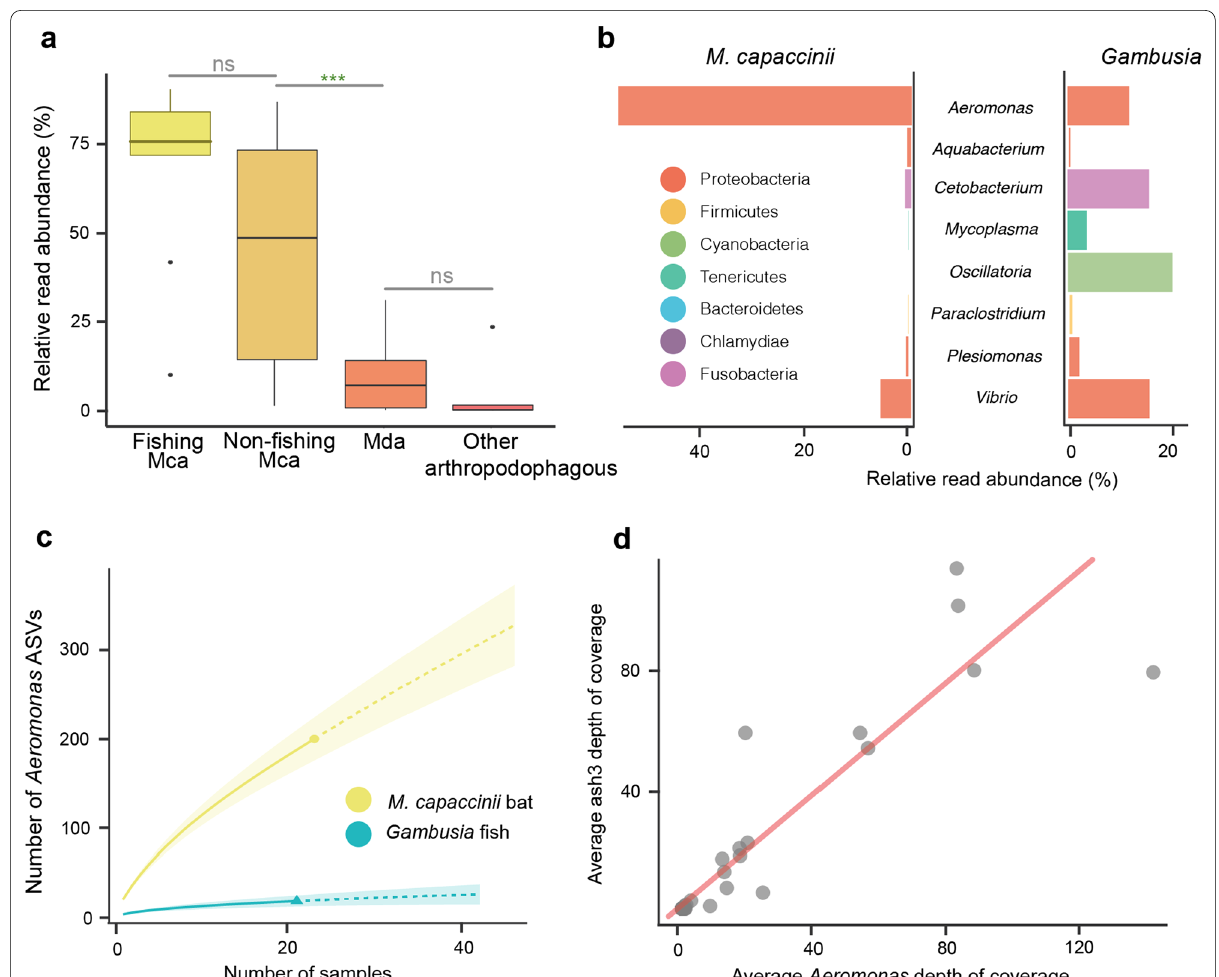
Fig. 5 a Cumulative relative representation of ASVs detected in fish guts measured in different groups of bats. b Relative representation of bacteria in the intestinal tracts of M. capaccinii and Gambusia. c Number of Aeromonas ASVs detected in M. capaccinii bats and Gambusia fish. d Depth of coverage of Aeromonas and ash3 (aerolysin precursor) gene recovered from bat shotgun